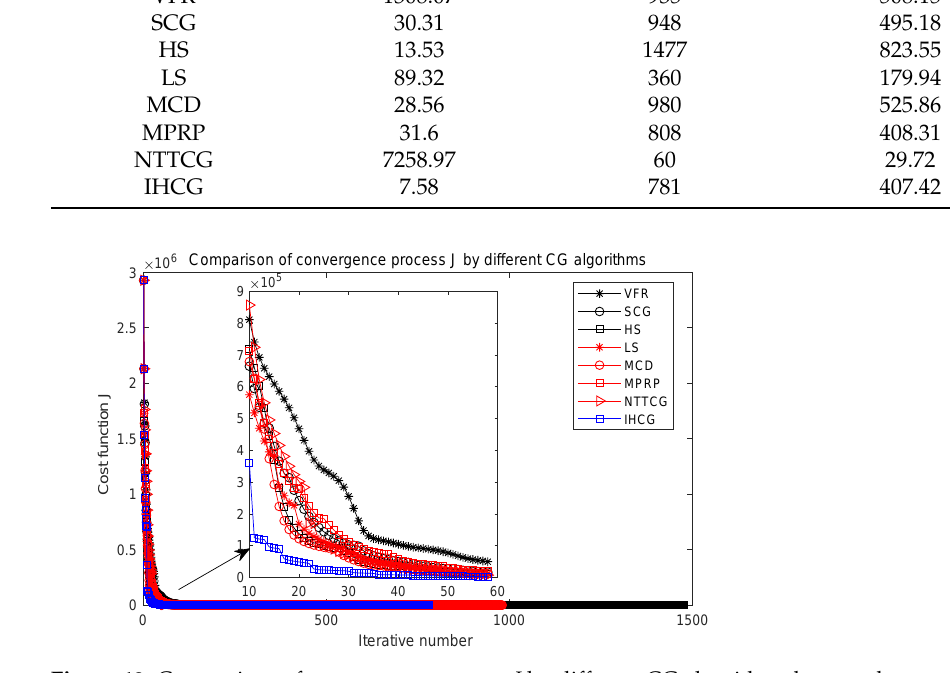
Figure 13. Comparison of convergence process J by different CG algorithms by actual measured data. The identified total heat exchange factor based on actual measured data